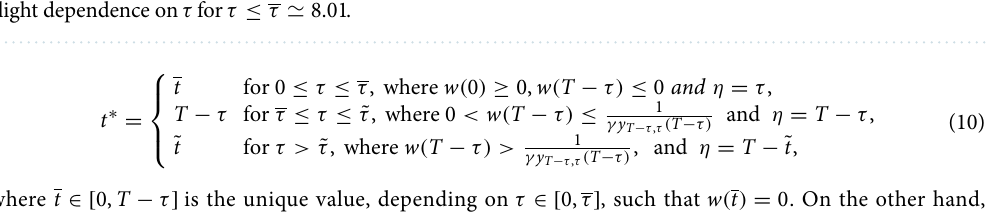
Figure 5. ( a ) Optimal initial time t ∗ vs strict quarantine length τ for κ = 0 and w ( 0 ) > 0 . ( b ) and ( c ) Graphical determination of the times τ and ˜ τ , respectively, which define the three regions for the different behaviours of t ∗ . The parameters are γ = 0.1, σ f = 1.5, σ s = 0.3, T = 260 . The initial condition corresponds to x ( 0 ) = 1 − 10 − 6 , y ( 0 ) = 10 − 6 . The optimum time for the region τ > ˜ τ ≃ 23.87 is ˜ t ≃ 236.13 , while t ∗ has a slight dependence on τ for τ ≤ τ ≃ 8.01